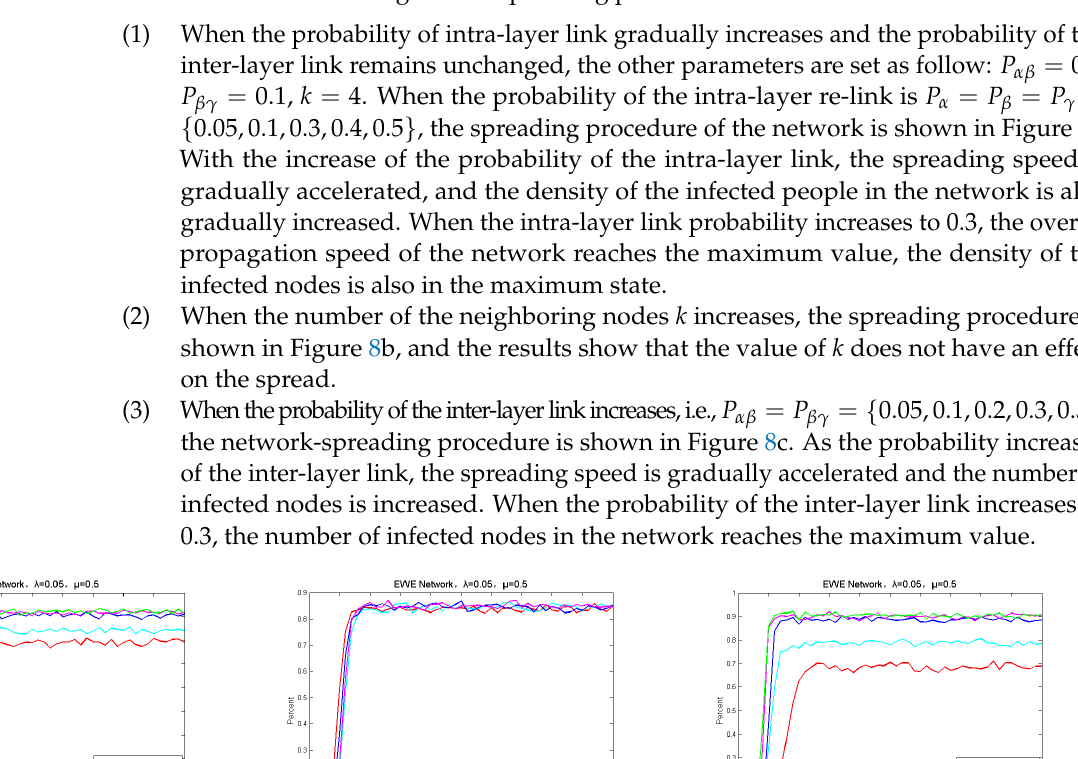
Figure 6. The spreading trends of three kinds of three-layer complex network under the same aver- age degree.